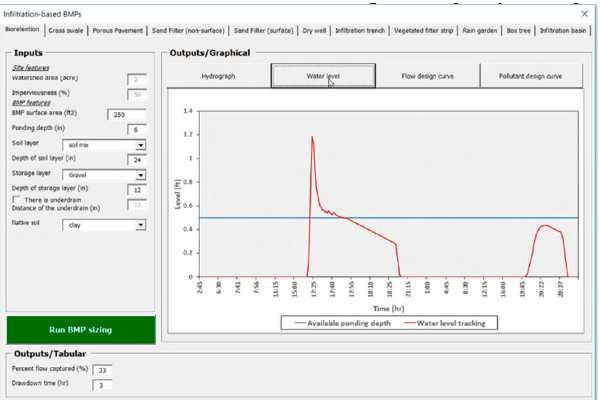
Figure A17. Output hydrograph for infiltration-based BMPs.